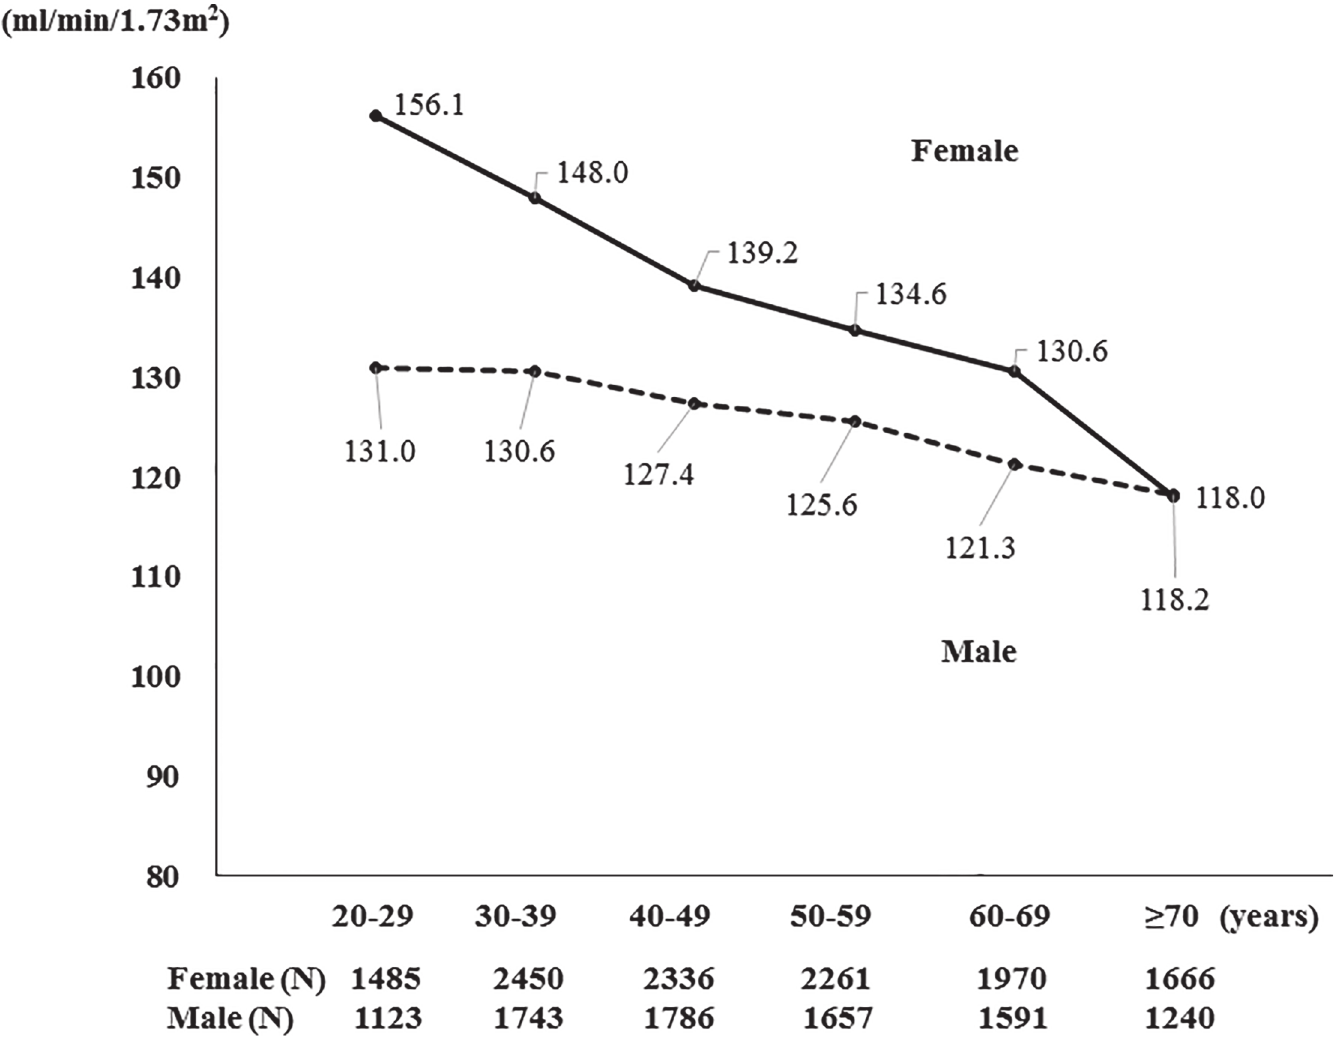
Fig 2. Distribution of estimated glomerular filtration rate by sex and age. The 97.5th percentiles are shown in 10-year age groups. Hyperfiltration was defined as an estimated glomerular filtration rate (eGFR) over the age- and sex-specific 97.5th